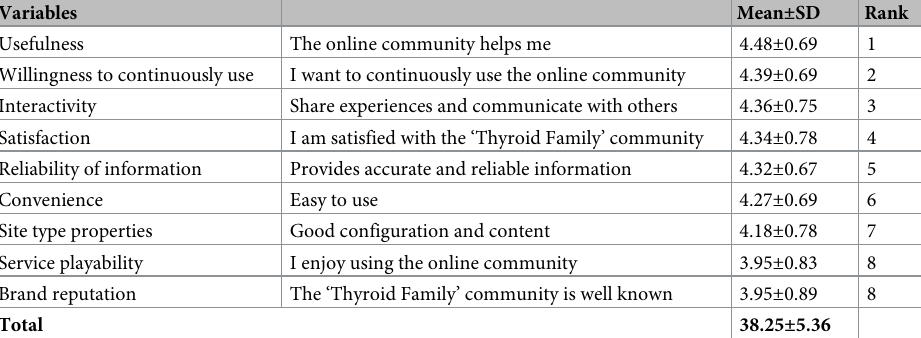
Table 5. Patient satisfaction with using an online health community (n =